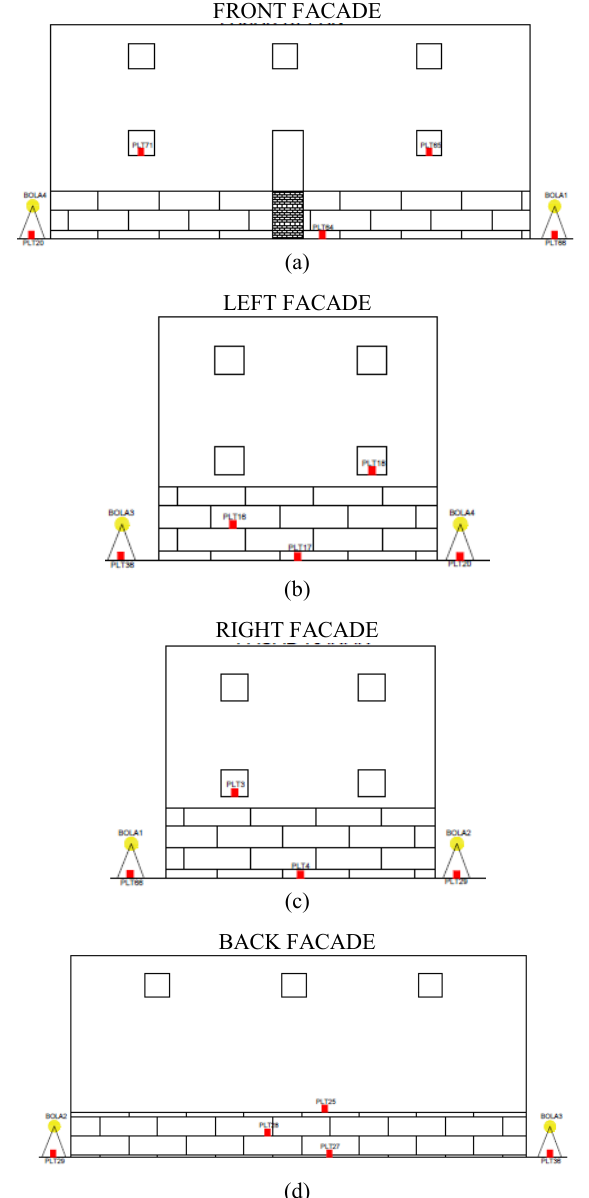
Figure 4. Sketch of the temple’s façades: (a) front, (b) left, (c) right), and (d) back. The red rectangles denote detail points (PLT#) measured using the total station, while the yellow spheres denote the artificial spheres (BOLA#) used in TLS registration, also known in